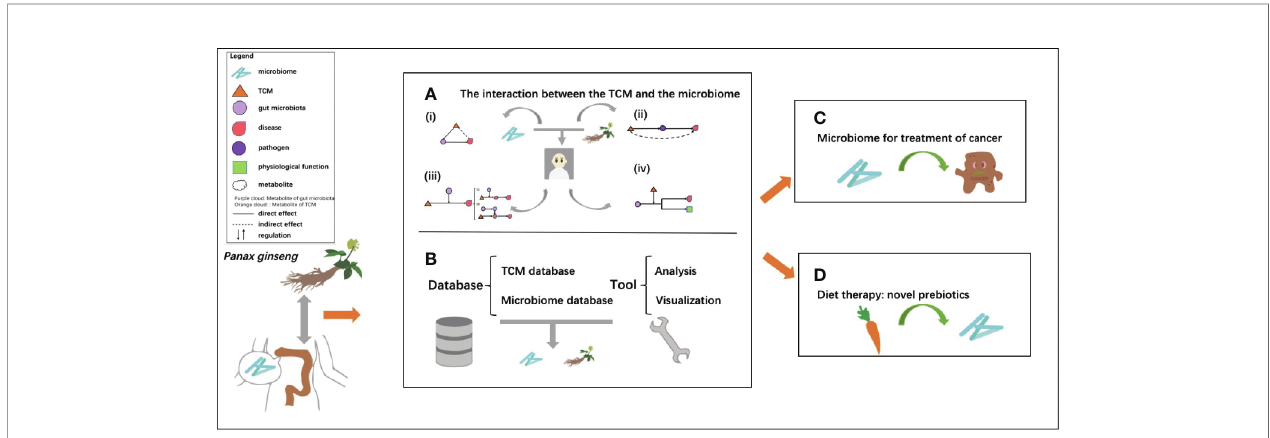
FIGURE 1 | The general framework of the review. (A) The interactions between traditional Chinese medicine (TCM) and the microbiome, which are mainly divided into four types: (i) regulation effect of TCM on the microbiome, dysbiosis of intestinal fl ora is restored by TCM; (ii) TCM's broad-spectrum antibacterial effect to prevent the infection with pathogenic bacteria; (iii) mediation of gut microbiome on TCM, the main active ingredients of TCM are biotransformed by the microbiome; (iv) mediation effect of drugs and TCM on microbiome through gene regulation; (B) the related databases, including TCM databases and microbiome databases and tools for analysis and visualization for research of TCM and the microbiome; (C) microbiome as a key orchestrator for cancer treatment; and (D) food as a potential prebiotic for microbiome